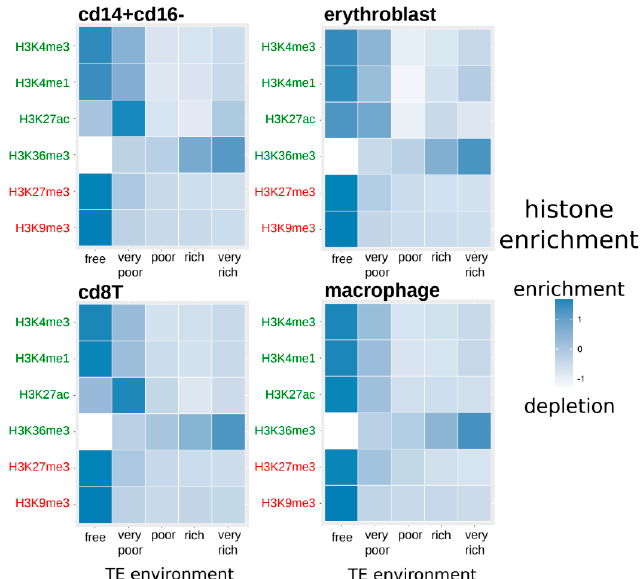
Figure 2. Normalized average histone enrichment of duplicated genes in each cell type according to the category related to their TE neighborhood (from TE-free to TE-very-rich genes). White color indicates a depletion in the considered histone modification and dark blue indicates an enrichment of the histone modification (Kruskal-Wallis tests, q -values < 0.05—supplementary Table S2). Activating and repressive histone modifications are represented, respectively, in green and red.